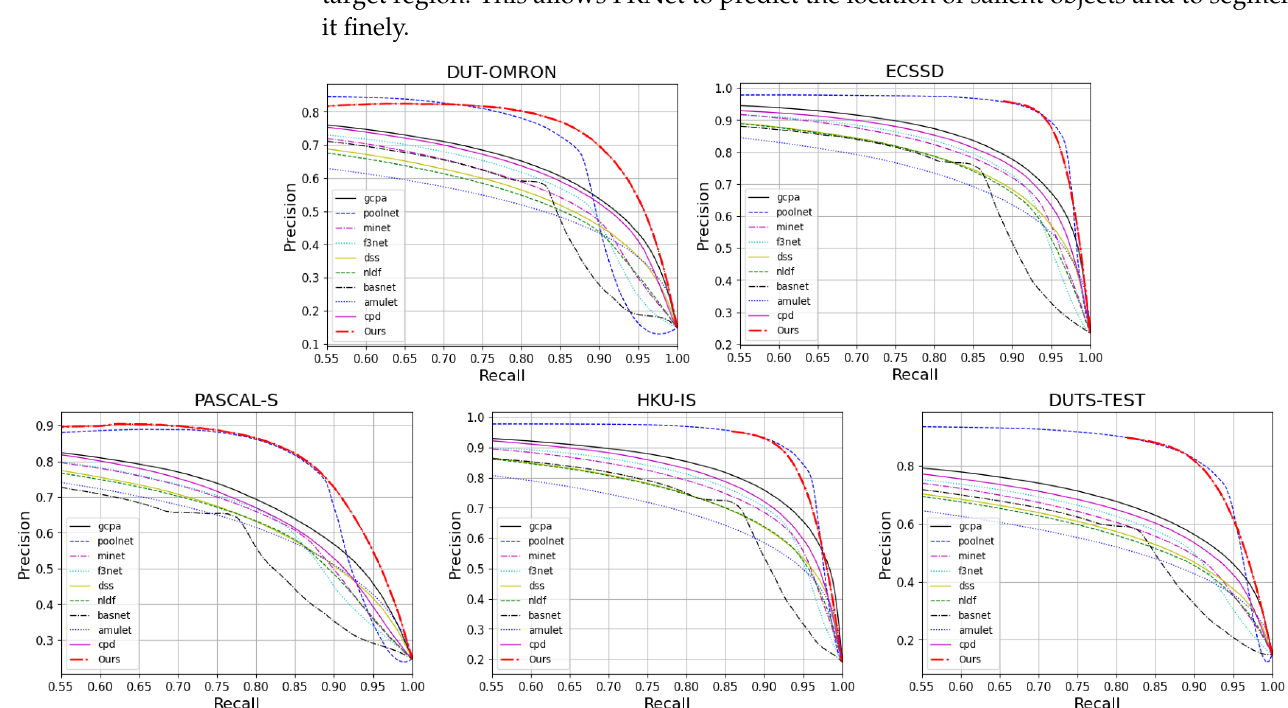
Figure 5. The PR curves of FRNet and the other nine advanced models on five